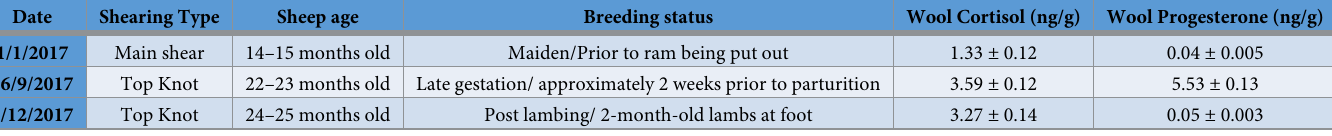
Table 1. Shows the wool sampling dates and morphometric, reproductive characteristics of the merino ewe sheep (n =